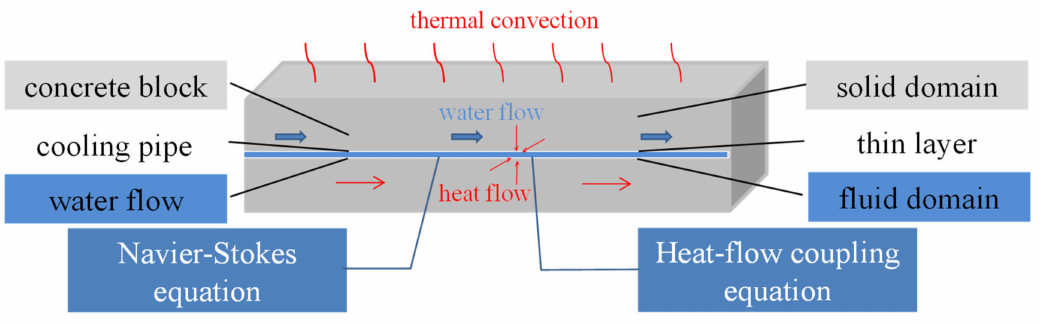
Figure 1. Schematic diagram of heat-flow coupling of pipe cooling in